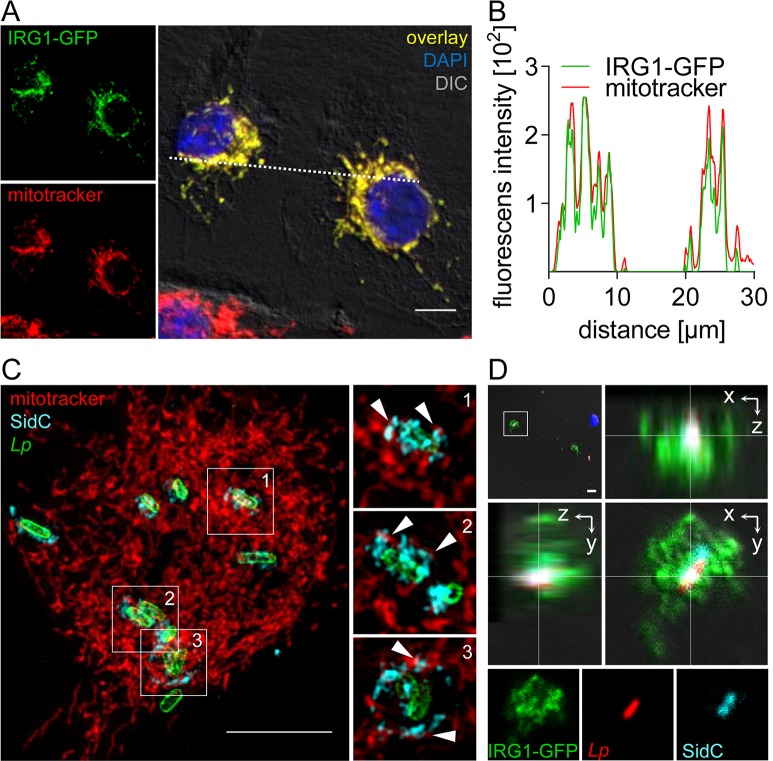
Mitochondrial IRG1 closely associates with LCVs.(A, B) Ifnar
-/- BMMs overexpressing IRG1-GFP (green) were stained with mitotracker (red), fixed and nuclei were visualized by DAPI (blue) staining. Images represent maximum intensity projections of z-stacks of 10 individual 1.4 μm thick sections. (B) Fluorescence intensity profiles of IRG1-GFP and mitotracker along the dotted line in (A) are depicted. (C) Super-resolution fluorescent image generated by structured illumination microscopy of BMMs stained with mitotracker (red) and subsequently infected with L. pneumophila for 2 h. Bacteria and LCVs were visualized in fixed cells by L. pneumophila (green) and SidC (LCV-located L. pneumophila-protein; cyan) staining, respectively. Large overview image represents maximum intensity projection of a z-stack of 30 individual 0.126 μm thick sections. Enlarged sections in the left panel depict one single confocal plane for each selected LCV according to numbers in the overview image. White arrowheads point towards close associations of mitochondria with the LCV membrane. (D) Ifnar
-/- BMMs overexpressing IRG1-GFP were infected with DsRed-expressing L. pneumophila wt (red). 2 h p.i. cells were homogenized and LCVs and nuclei were visualized by SidC (LCV-located L. pneumophila-protein; cyan) and DAPI (blue) staining. Framed area from the upper left overview image is shown as orthogonal view of a z-stack of 8 individual 0.68 μm thick sections and as single channels for depicted section. (A, C, D) Scale bars indicate 5 μm.